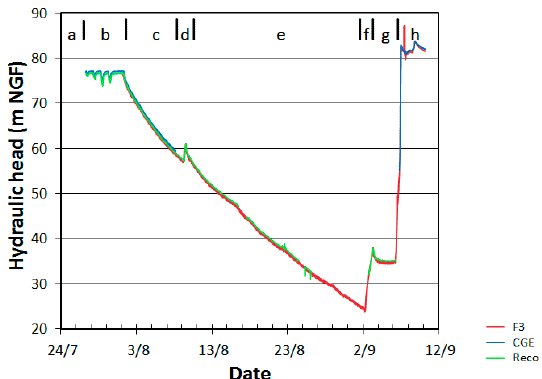
Figure 5. Hydraulic head recorded in the CGE, F3 and Reco boreholes. Letters (a to g) refer to periods